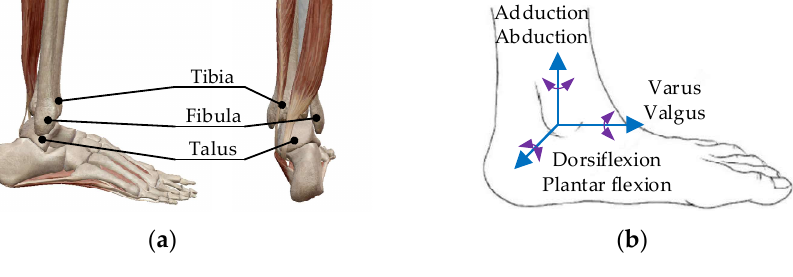
Figure 1. ( a ) The ankle bone structure; ( b ) the ankle motion model.